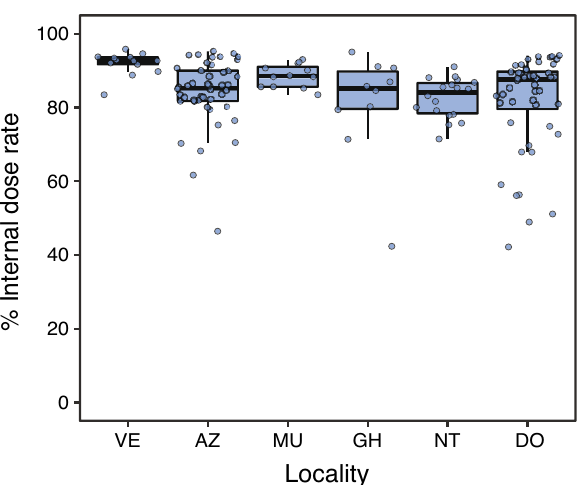
Figure 3. Contribution of internal dose rates (in percentage) to total individual dose rates absorbed by breeding Eastern tree frog ( Hyla orientalis ) males collected within the Chernobyl Exclusion Zone (only in individuals from localities with ambient dose rate > 1 μSv/h). See Fig. 1 for correspondence of locality.